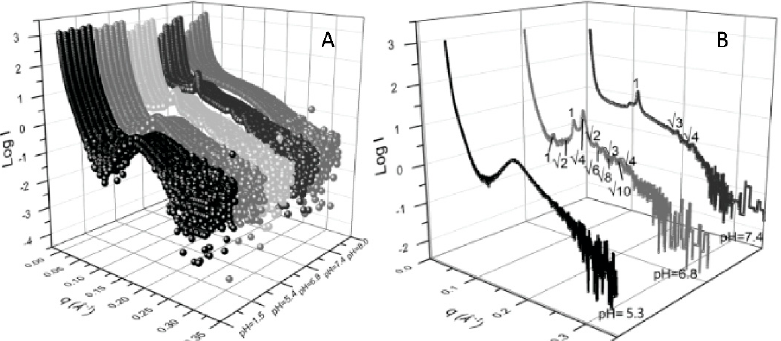
Figure 2. ( A ) SAXS patterns obtained from nanoparticles of different composition (front to back: MO:OA, MO:0.9OA:0.1BJO, MO:0.8OA:0.2BJO, MO:0.7OA:0.3BJO, MO:0.6OA:0.4BJO and